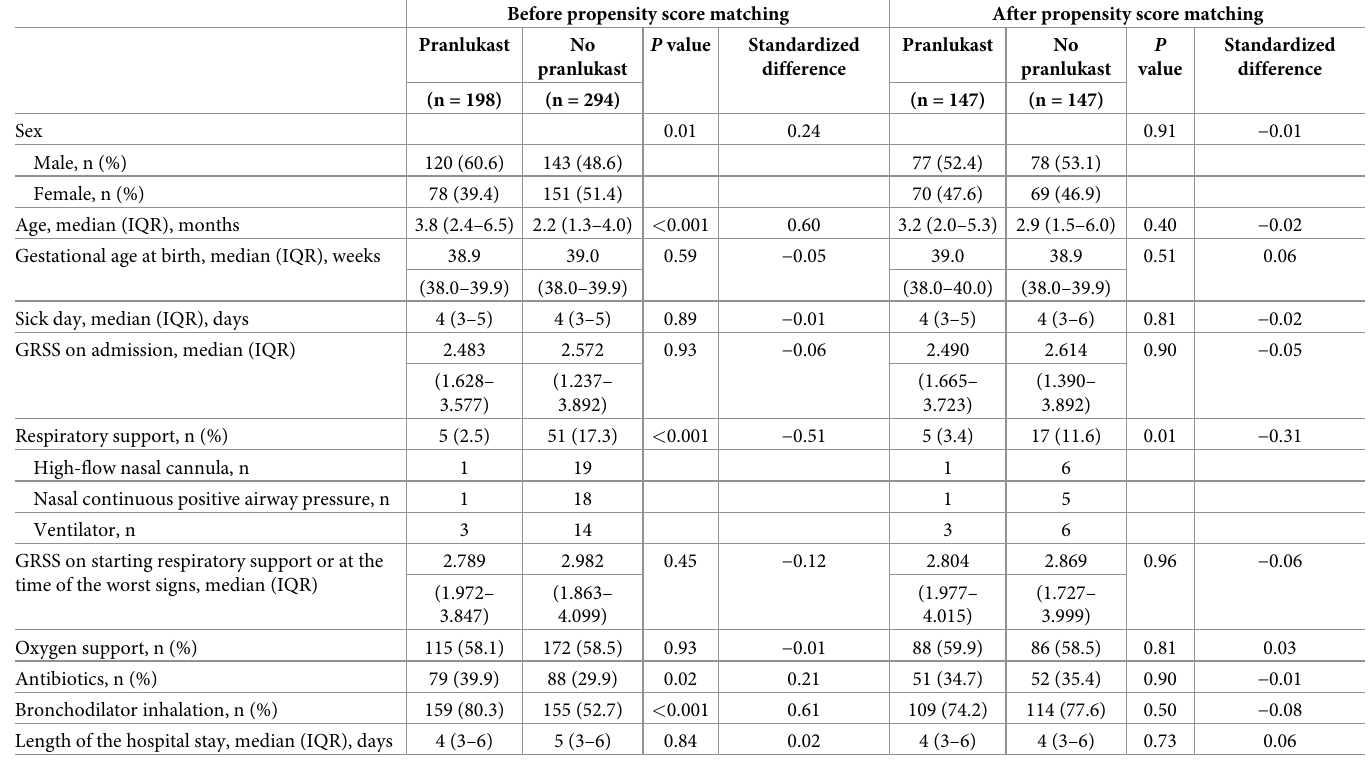
Table 1. Baseline characteristics of the study patients before and after propensity score matching.